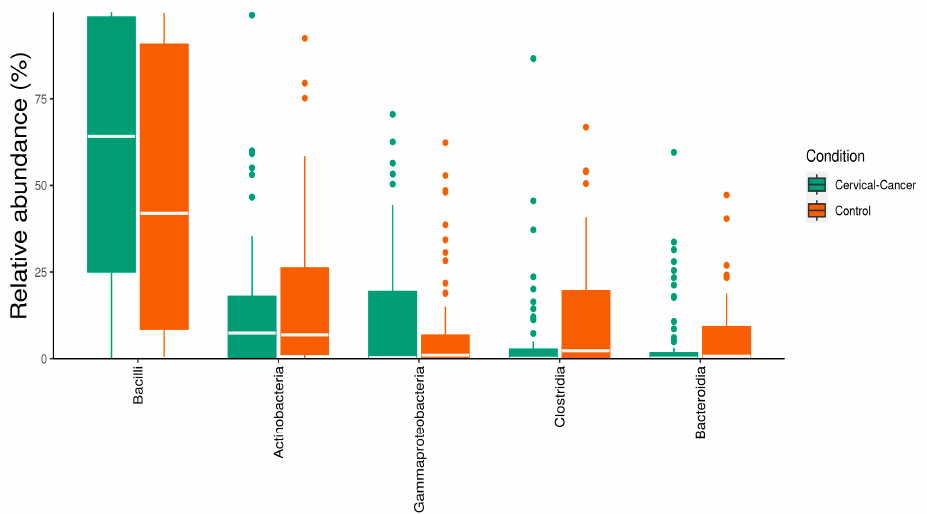
Figure 1 . Alluvial plot depicting the taxonomic abundance of ASVs associated with the samples at a phylum level.